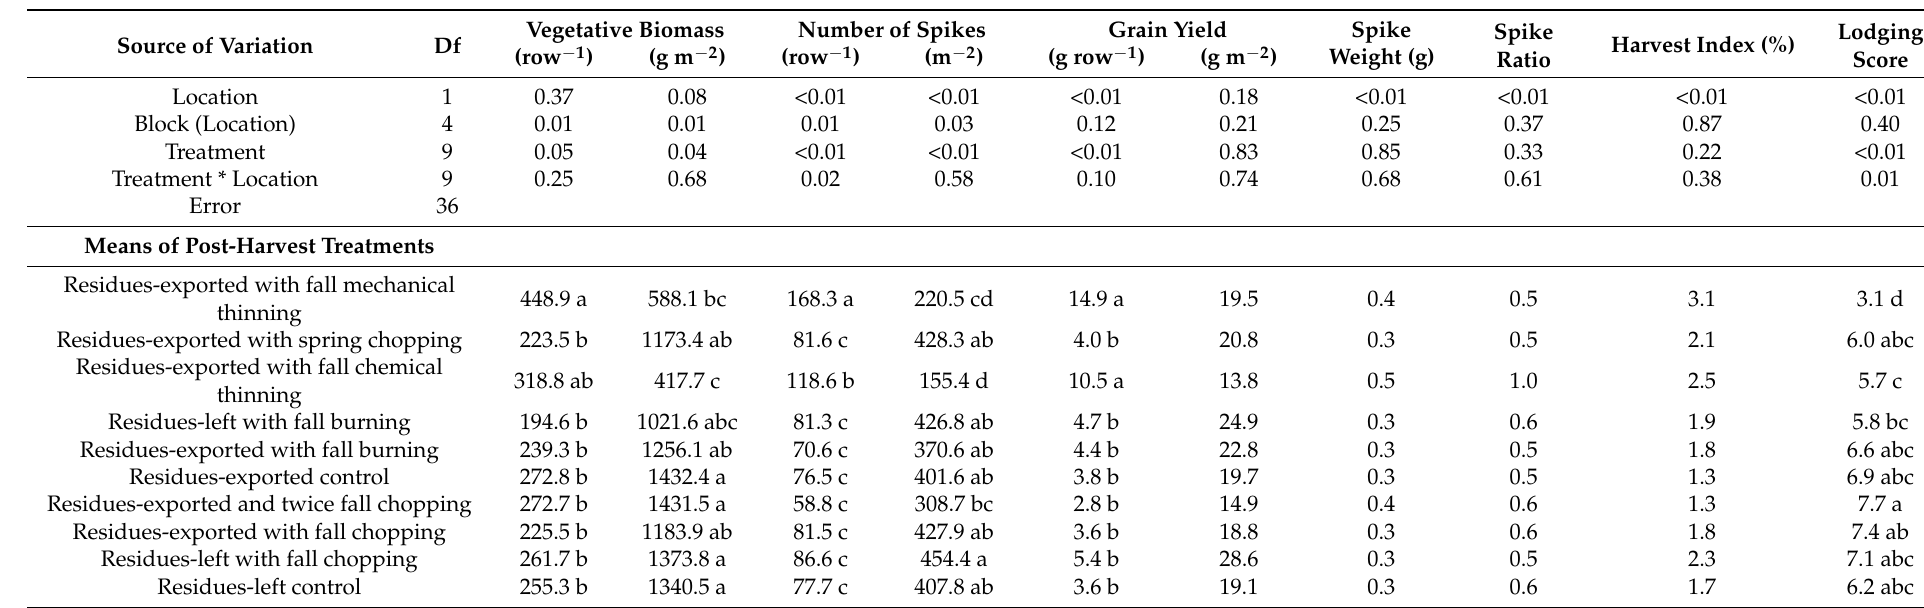
Table 1. p -values for the analysis of variance and means for Kernza Intermediate wheatgrass ´ s vegetative biomass, number of spikes, and grain yield row − 1 and m − 2 , and spike weight, spike ratio, harvest index, and lodging score under 10 different management treatments at the second-year harvest at two locations (Lancaster and Montford 1 , WI,